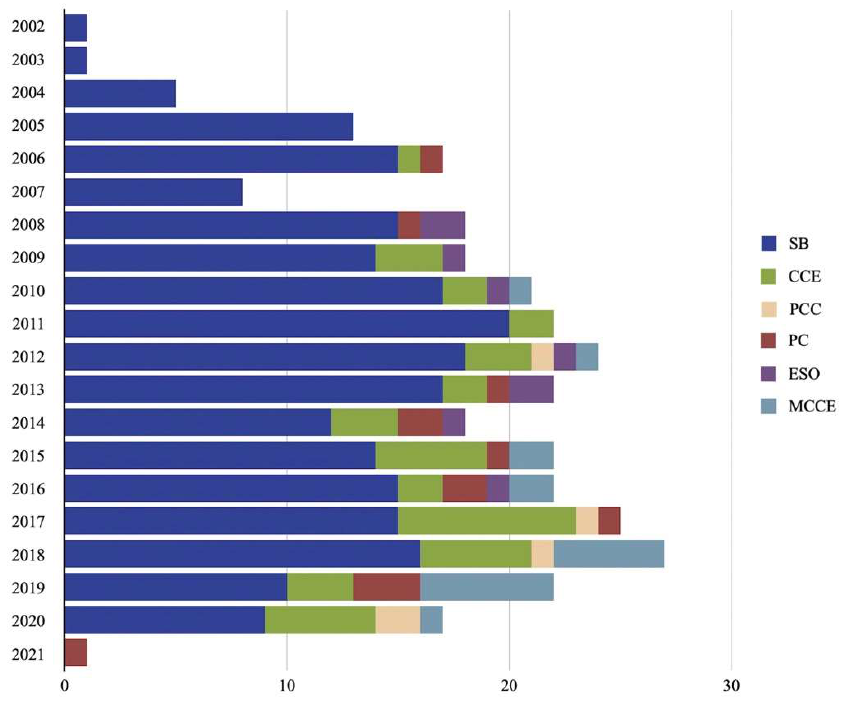
Figure 1. Yearly publication of included studies per type of capsule.